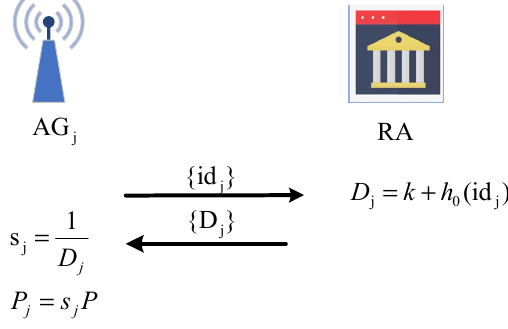
Figure 4. The process of AG j registration.